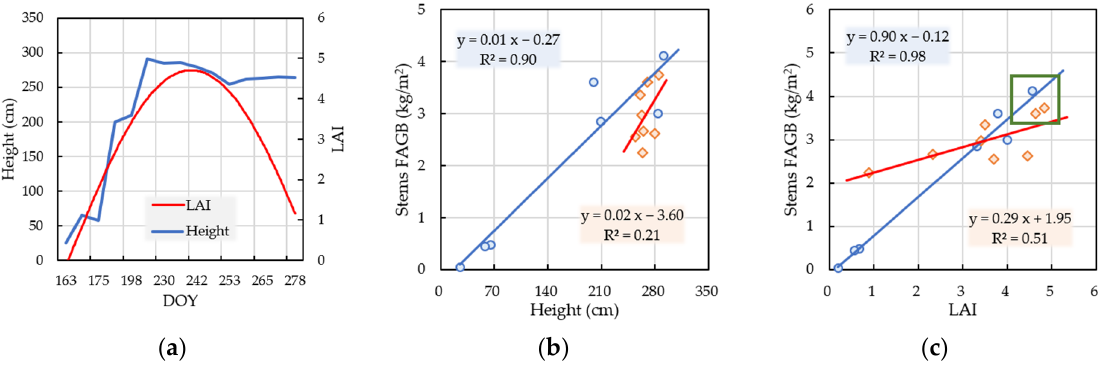
Figure 2. The characteristics of the maize LAI and height ( a ) and the fitted relationships, respec- tively, with the FAGB ( b , c ) for the entire growing season. with the FAGB ( b , c ) for the entire growing